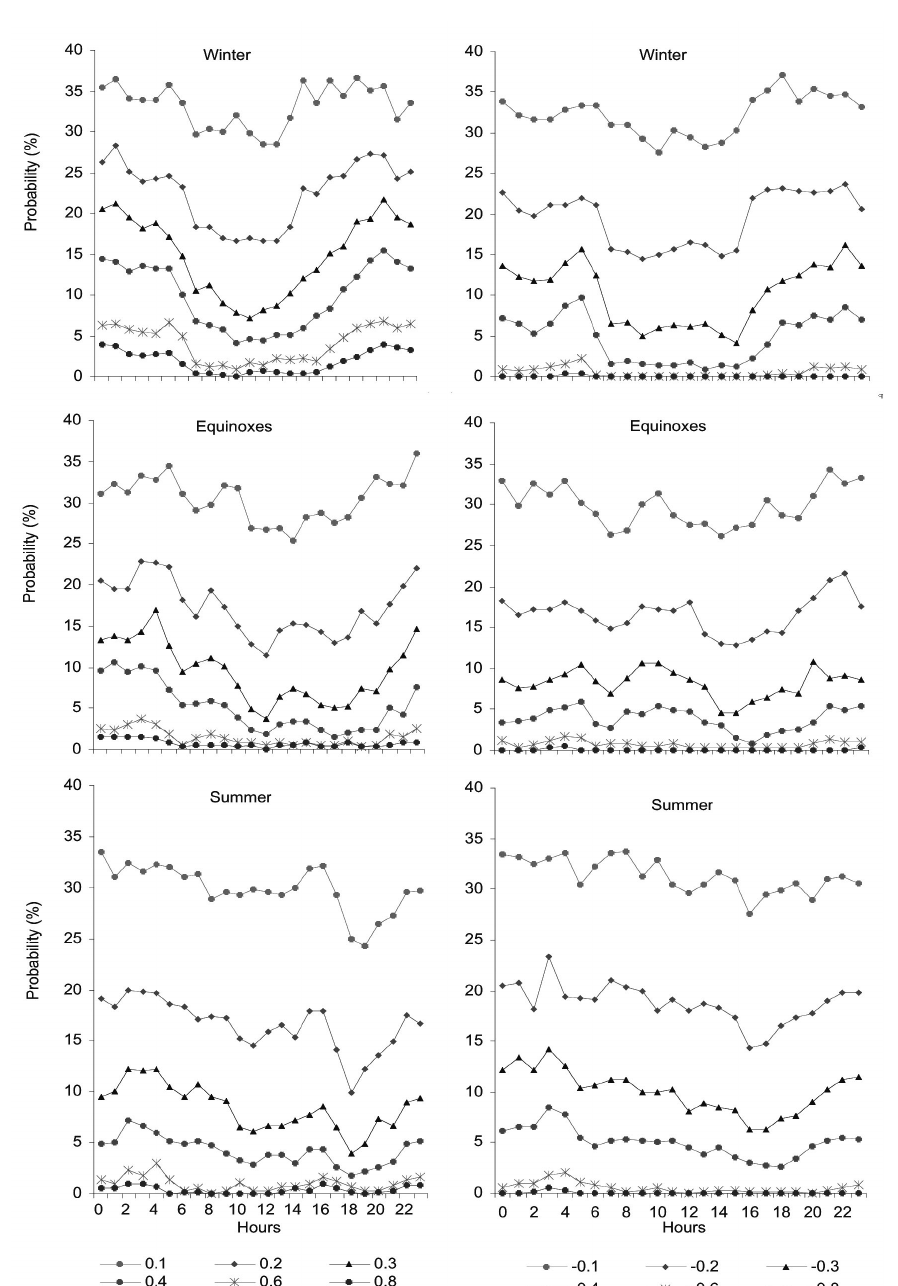
Fig. 9.3b. Probability that a given level, positive ( left ) or negative ( right ), of variability in TEC is exceeded at high solar activity